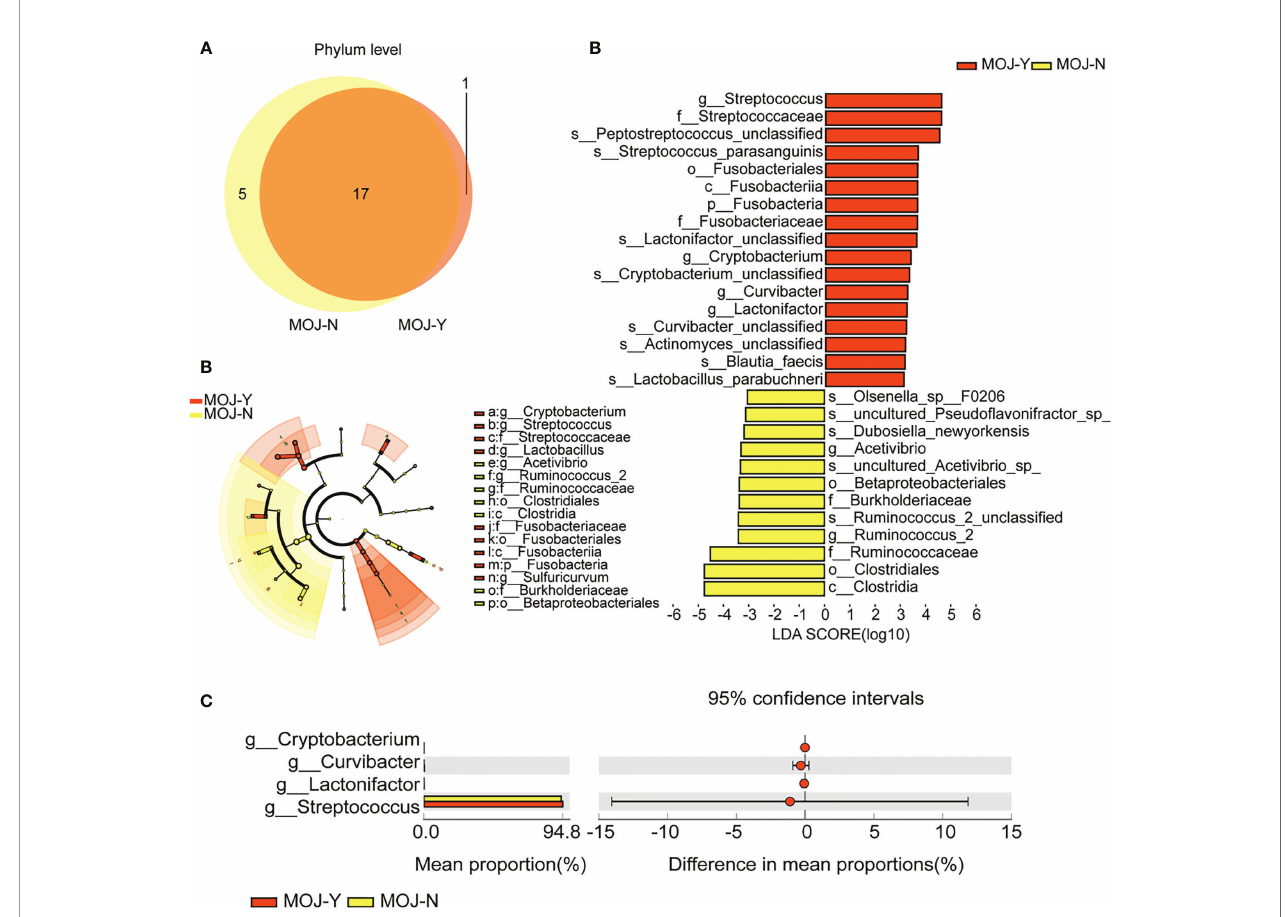
FIGURE 5 | The differences of gut microbiota among patients with malignant obstructive jaundice (MOJ-Y) or not (MOJ-N). (A) The differential microbial species were classi fi ed using Venn diagram. (B) Differentially abundant taxa between MOJ-Y and MOJ-N samples analyzed by linear discriminant analysis (LDA) effect size (LEfSe) were shown in histogram and cladogram. All listed taxa were signi fi cantly (Kruskal – Wallis test, P < 0.05, LDA score >3) enriched in their respective groups. (C) Relative abundances of four differentially expressed genera by the Statistical Analysis of Metagenomic Pro fi le. The left and right panels demonstrated the average relative abundance and the 95% con fi dence interval of each phylum in MOJ-Y and MOJ-N,